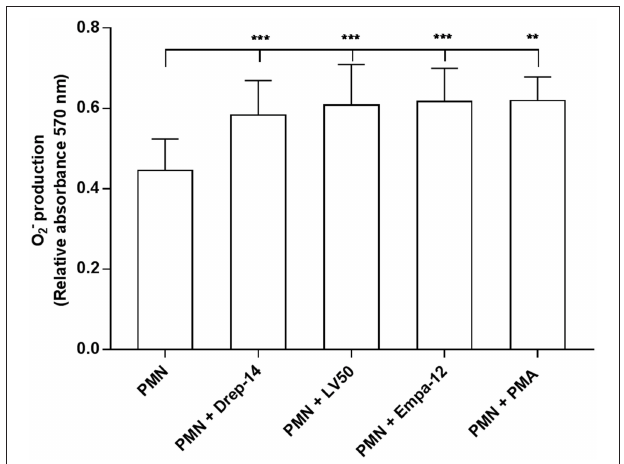
FIGURE 2 | Measures of oxidative burst in Leishmania infected neutrophils. PMNs, PMNs exposed to Leishmania promastigotes, and PMNs stimulated with 100nM PMA were incubated in triplicate in 96 well-plates in 100 µ L of RPMI-1640/ Glutamax medium plus penicillin (100 U/mL) and streptomycin (100 µ g/mL) supplemented with 5 % FBS containing 0.2 % NBT solution to quantify intracellular O 2 − production. After 18h of incubation at 37 ◦ C, in presence of 5 % CO 2 , blue formazan particles were generated after NBT reduction in activated neutrophils. Intracellular formazan deposits were then solubilized by adding 100 µ L of 10 % SDS / 0.1N HCl, and the absorbance of the solution was measured at 570nm. Data are shown as the mean values of O 2 − production from fourteen donors ± SD. Mann-Whitney test was used to compare the absorbance of Leishmania infected PMNs to control PMN cultures, and of the infected PMNs in a pair-wise manner; ** p < 0.01 and *** p < 0.001 indicate statistically significant differences at the indicated p